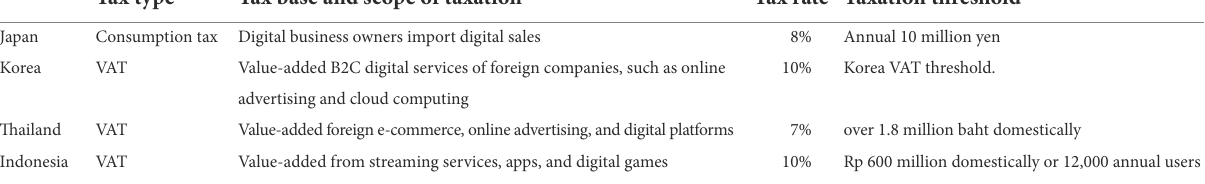
TABLE 3 Third scenario digital tax scenario for major